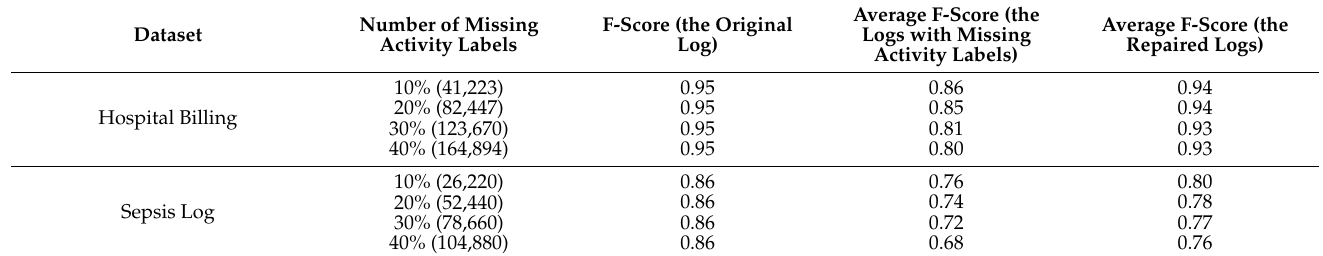
Table 11. F-scores of process models discovered by the split miner from the original, problem and repaired event logs. All conformance checking was conducted between discovered process models and the original event